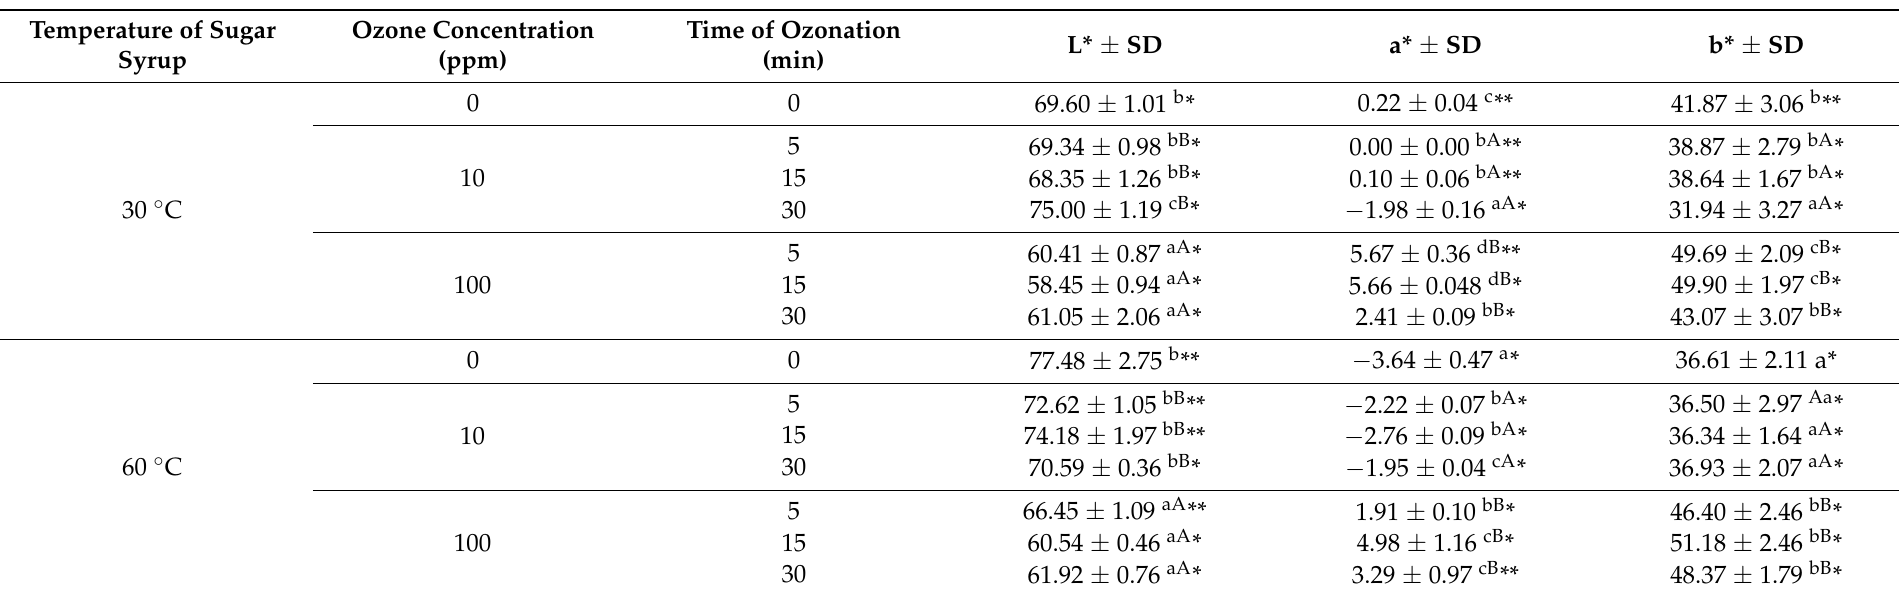
Table 3. Colour of syrups from flowers of black elder, relative to the temperature of water and dose of ozone applied to the raw materials. Temperature of